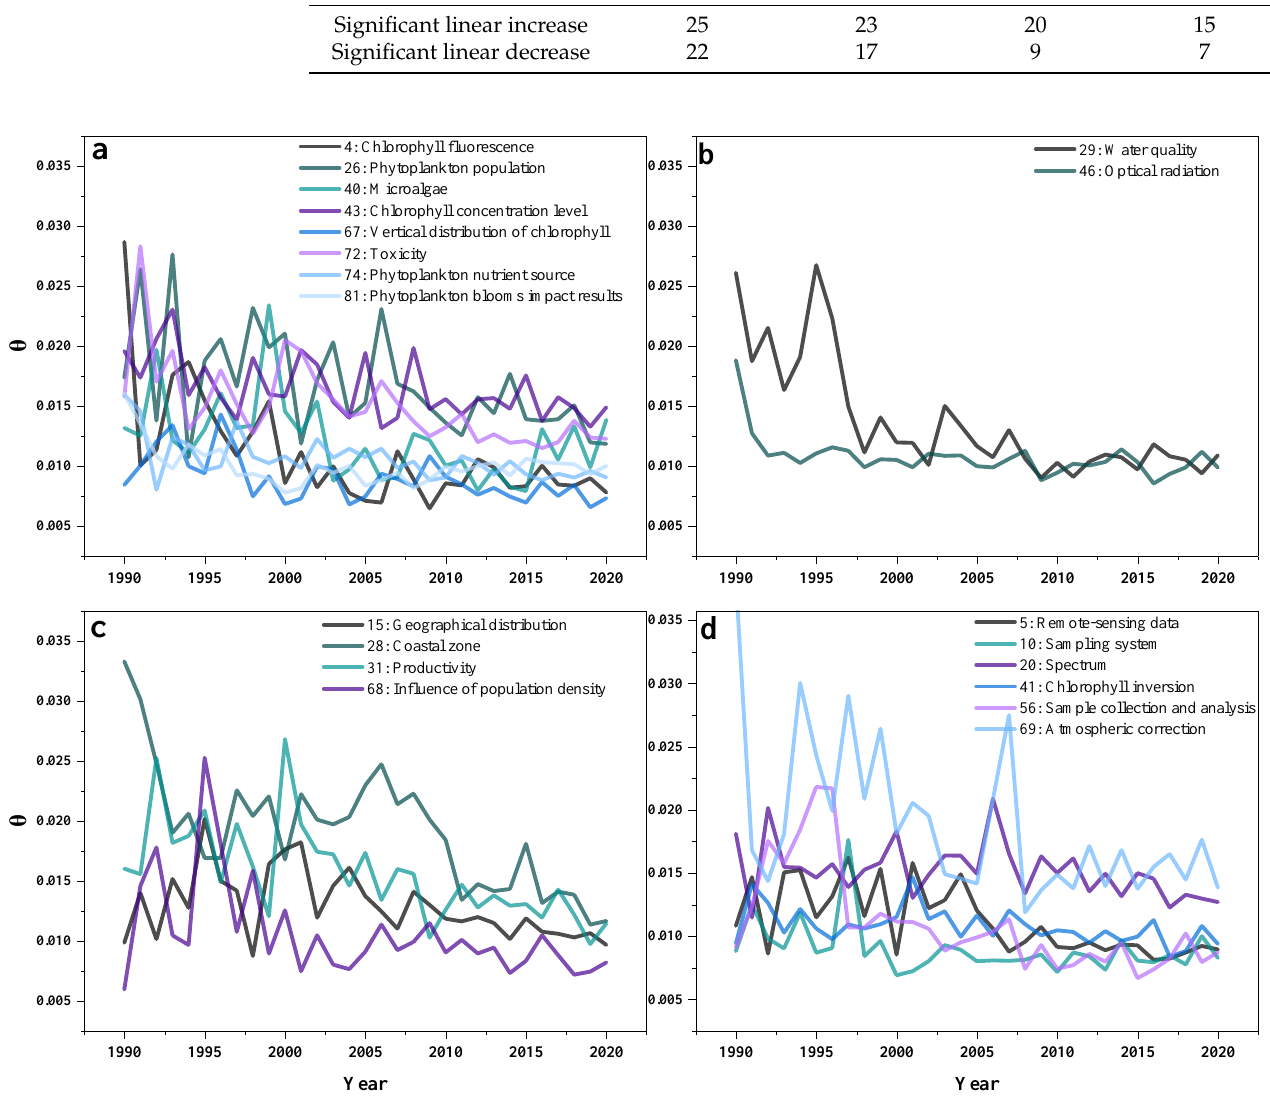
Figure 7. Cold theme tendency: ( a ) the subject of “algal (chlorophyll) changes,” ( b ) the subject of “temporal–spatial and environmental factors,” ( c ) the subject of “biological and geographic factors,” and ( d ) the subject of “remote sensing and methods.” The figure only shows topics with a significant linear decrease.